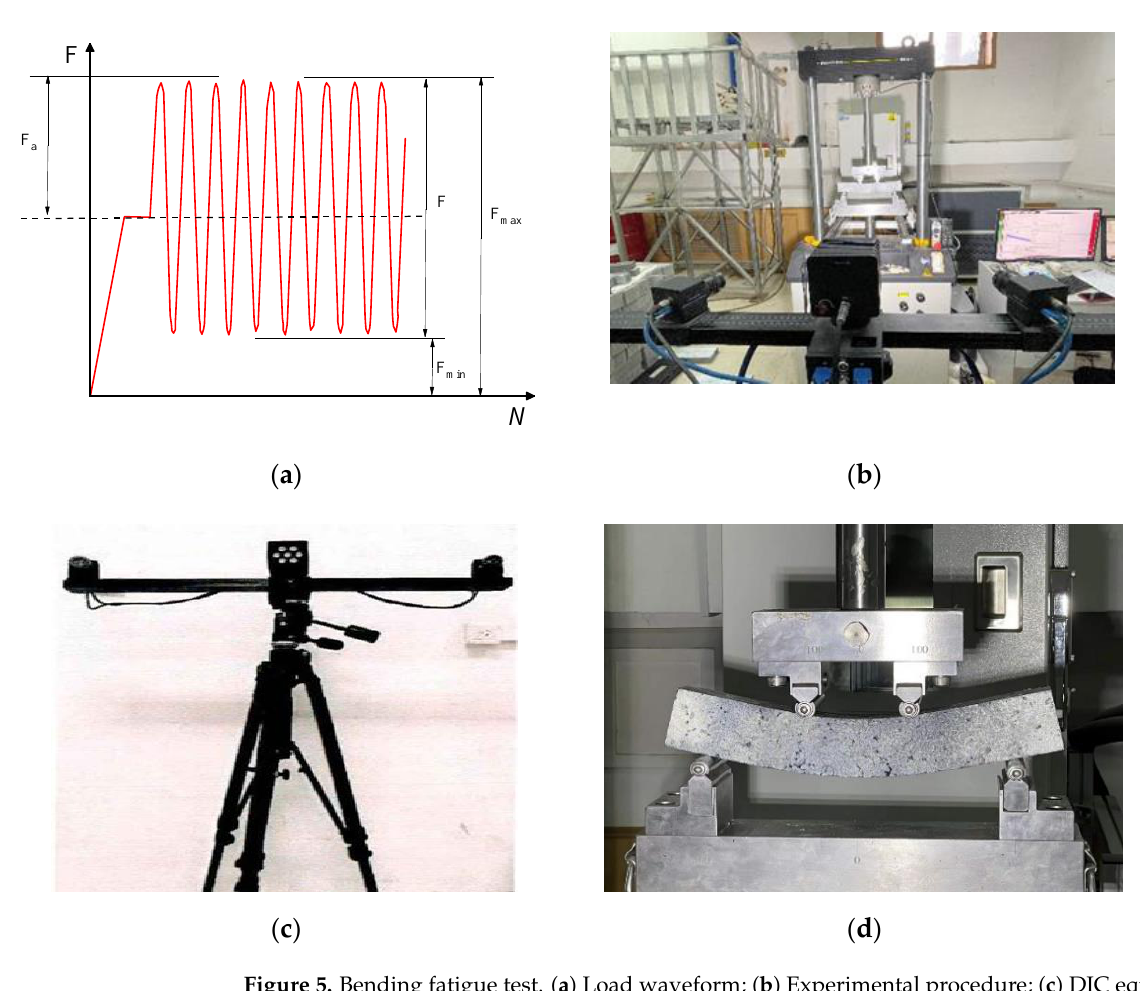
Figure 5. Bending fatigue test. ( a ) Load waveform; ( b ) Experimental procedure; ( c ) DIC equipment; ( d ) Bending state of the specimen.